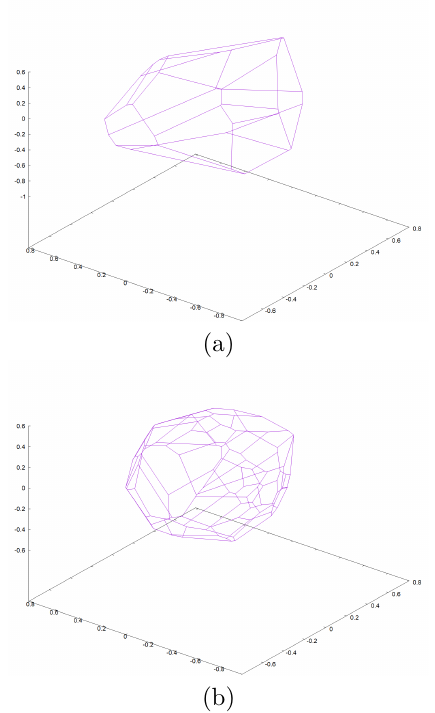
Figure 4. Concrete grains: (a) grain with higher flakiness index (elliptical); (b) cell with lower flakiness index (spherical).